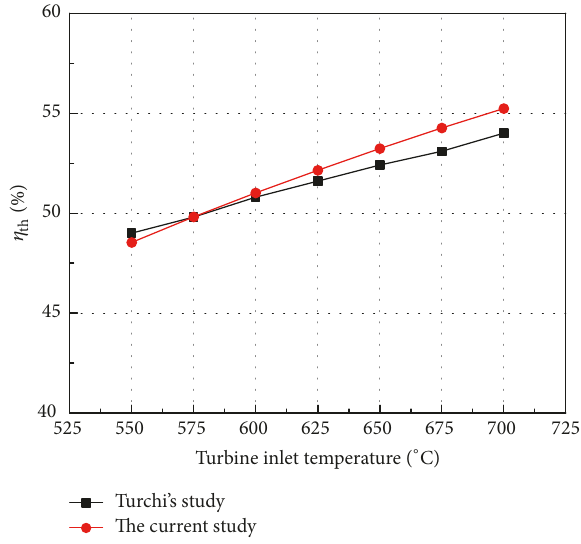
Figure 3: Validation of thermodynamic model by Turchi’s study.